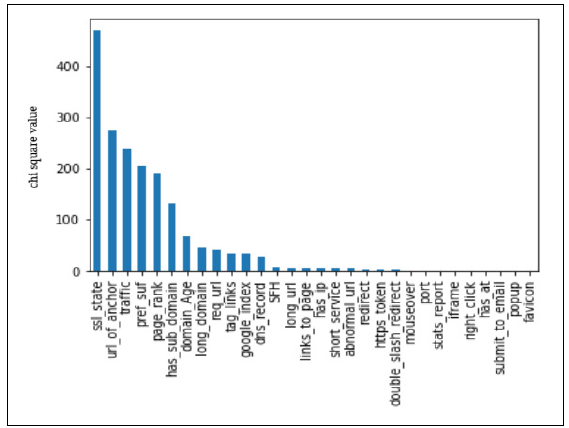
Figure 2. Chi-Square value against feature set Fig.2. shows the plot of features against the chi-square value. The top 15 features having high Chi-square value were selected for training the classification model.